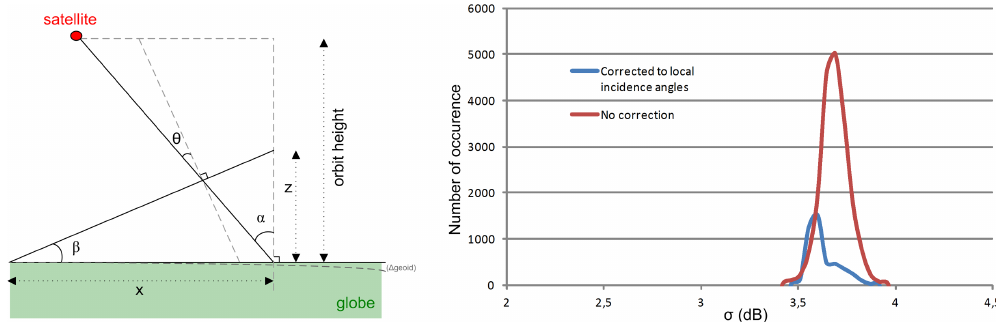
Fig. 12. Left panel: the difference between incidence angle α and local incidence angle θ is mainly caused by the terrain slope β . Right panel: a slice of the 2-D histogram at α =32.5 ◦ (location latitude–longitude=27.5–87.5). Corrections for the slope will shift the position of σ − α